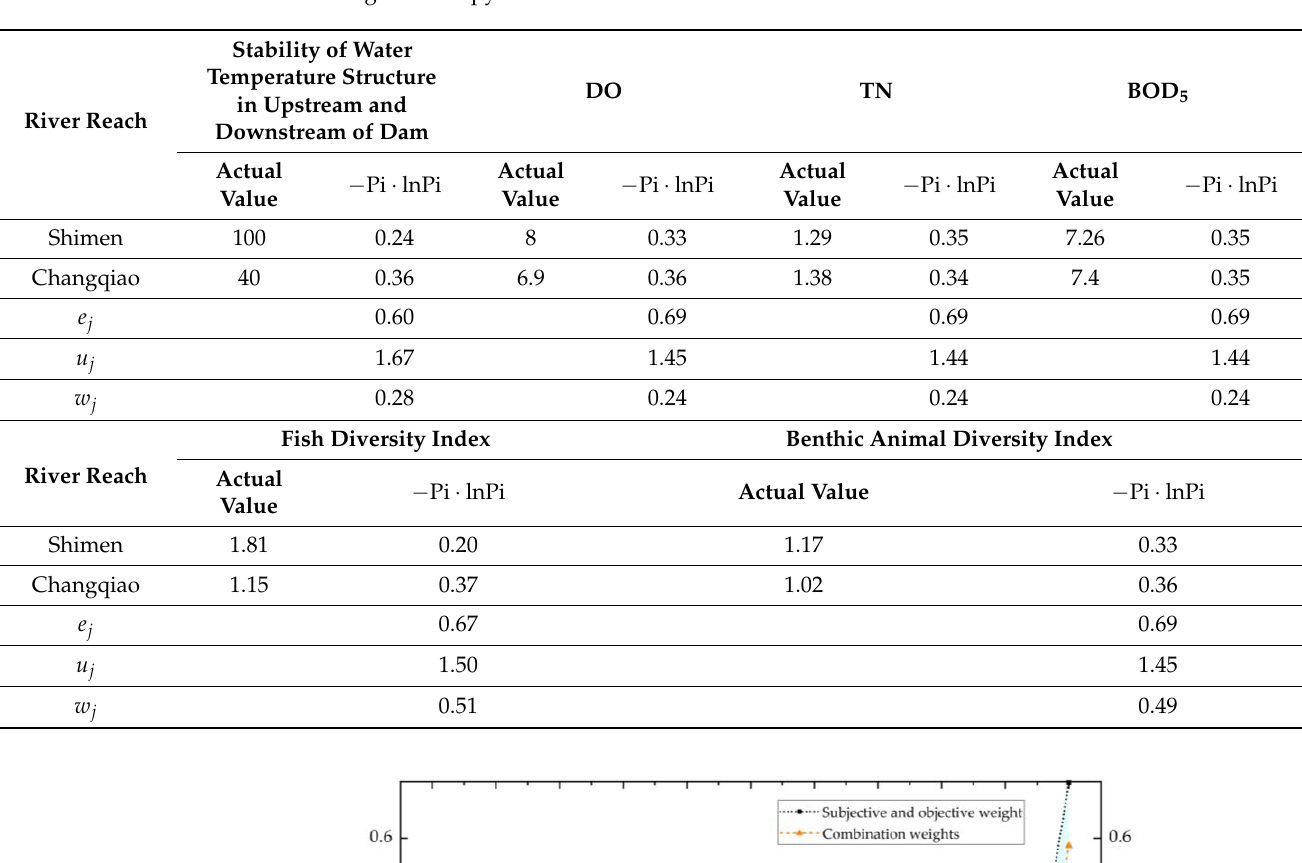
Table 4. Weight of water quality and biological characteristics index layer in Tufang River (2018) using the entropy method.